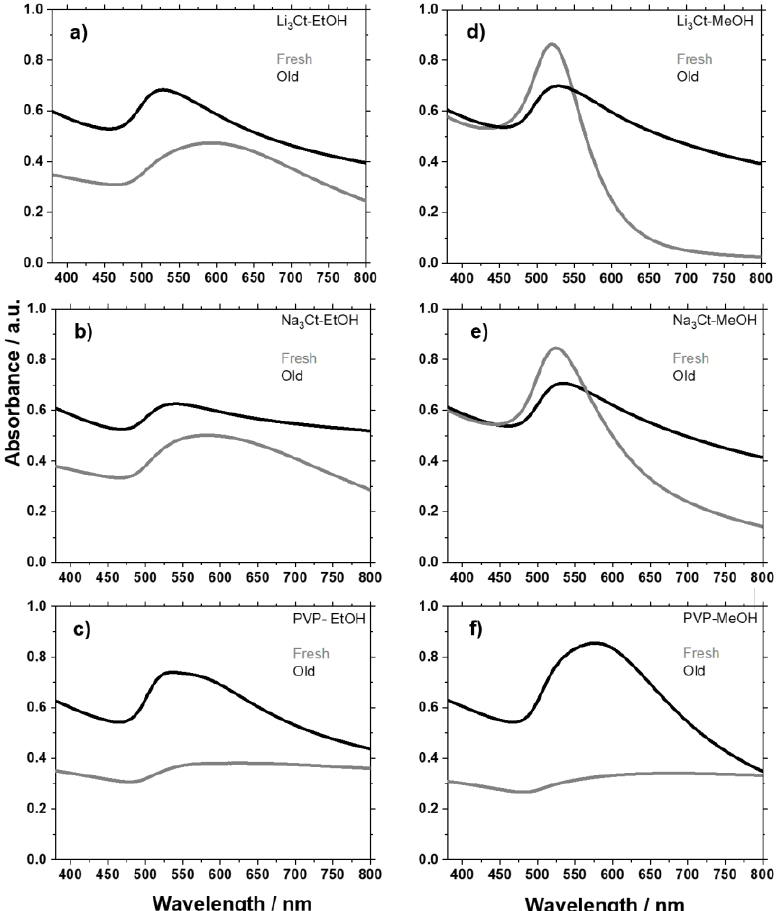
Figure 3. UV-vis characterization of Au NMs obtained by a RT synthesis using different surfactants as indicated and 30 v.% ( a – c ) EtOH and ( d – f ) MeOH as the reducing agent and prepared using a fresh or an old stock solution of NaOH and additives (Li3Ct, Na3Ct, PVP), as indicated.